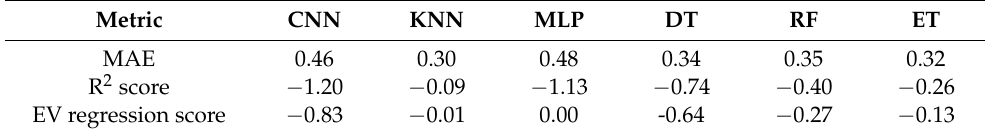
Table 9. Evaluation metrics for validation set of the hologram dataset.